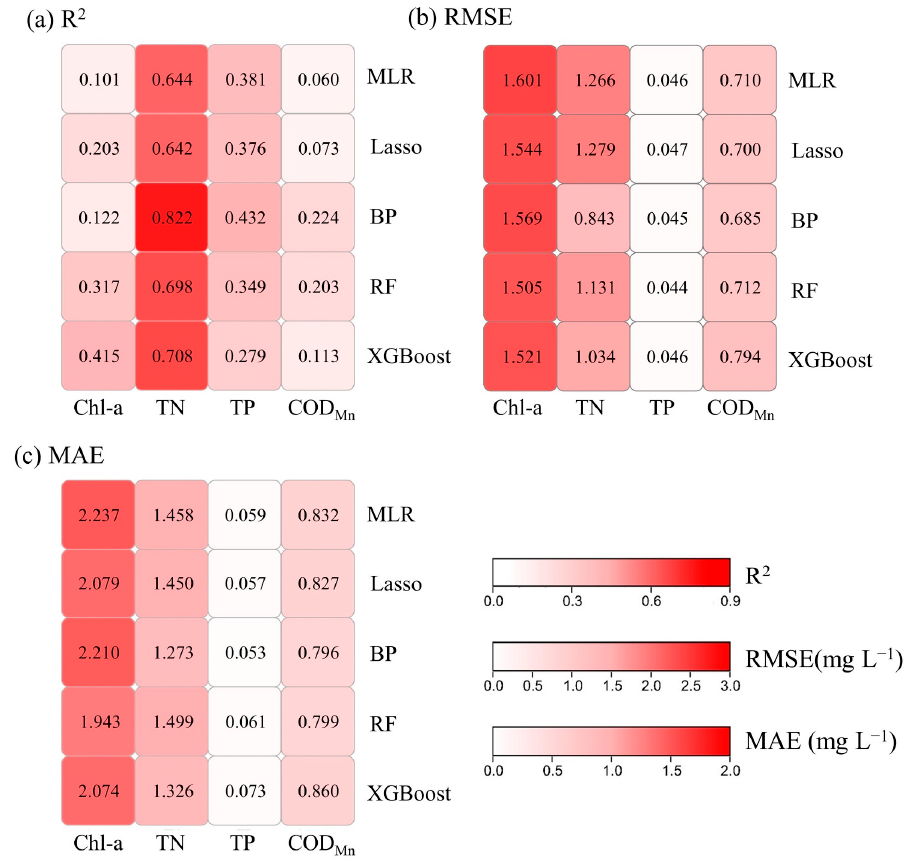
Figure 6. Comparison of predicted and measured water quality parameters using different single ML methods: ( a ) R 2 , ( b ) RMSE, and ( c ) MAE.